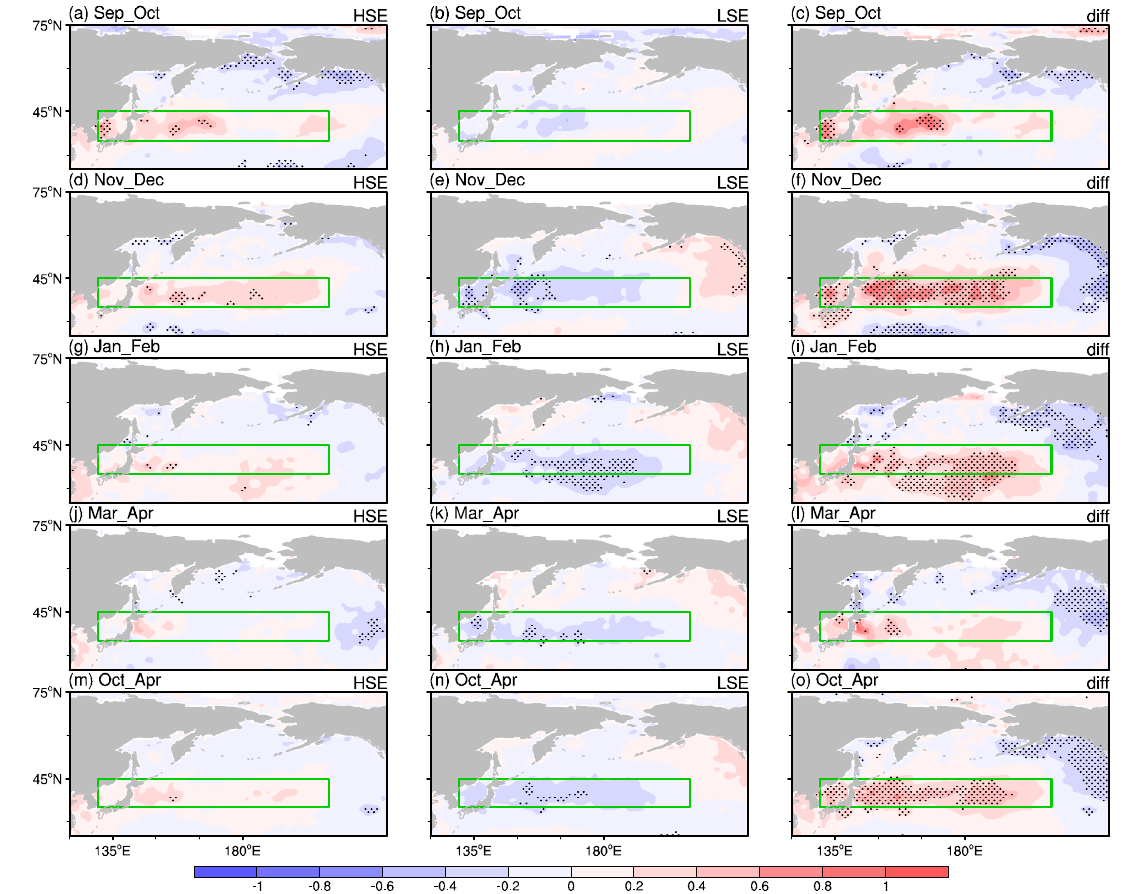
Figure 10. Composite differences in sea surface temperature (SST) (units: °C) in the preceding September–April in the composites of more HSE years and more LSE years in wintertime over NEC: rows are for each bi-month; columns (from left to right) are the anomalies in the composite of more HSE years ( a , d , g , j , m ), anomalies in the composite of more LSE years ( b , e , h , k , n ), and anomalies in the difference between the composites of more HSE years and that of more LSE years ( c , f , i , l , o ). The SST index is defined based on the green box region (35°–45° N, 130°–210° E). Stippling denotes where anomalies are significant at the 90% confidence level.